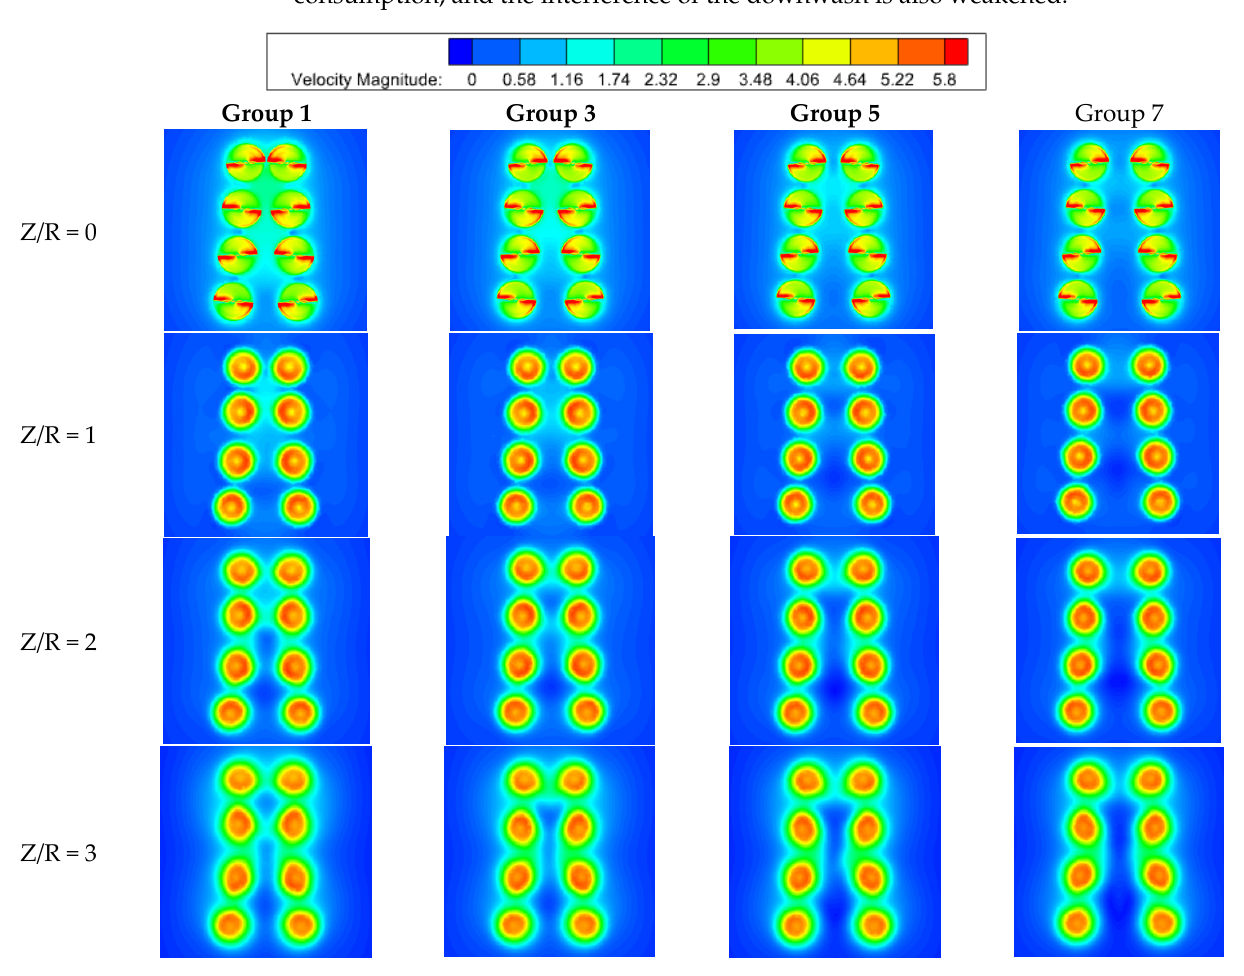
Figure 12. Velocity